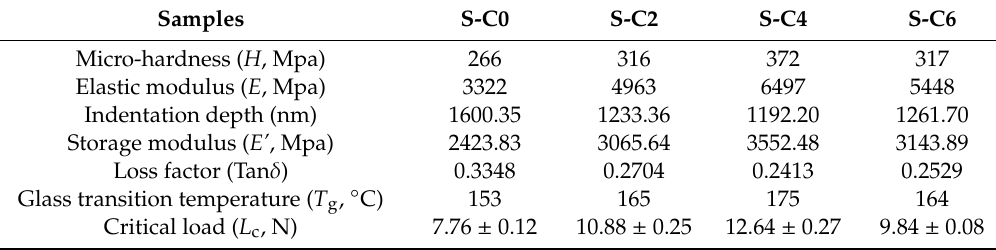
Figure 6. Panorama images of the blank polymer matrix and the nanocomposite coatings after scratch Table 1. Representative parameter values extracted from mechanical tests of nanocomposite